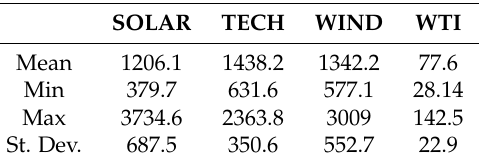
Table 2. Descriptive Statistics of the Global Solar Energy Index (SOLAR), Global Energy Smart Technologies Index (TECH), Global Wind Energy Index (WIND), and West Texas Intermediate (WTI) between 2006 and 2016. SOLAR TECH